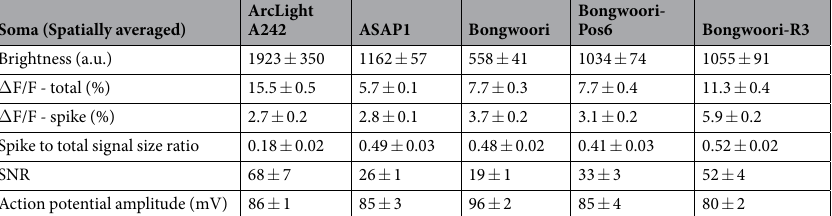
changes in voltage by altering its conformation. The linker domain couples the movement of the FP to the con- formational change of the VSD. The FP domain provides the optical output. The FP domain has been shown to dimerize enabling the conformational change in the VSD to alter the environment of the chromophore thereby eliciting a fluorescent signal. Introduction of mutations that decrease the affinity of the FP to dimerize reduce the optical signal by over 70% 15 . Mutations to the VSD have improved the speed and the voltage range of the optical